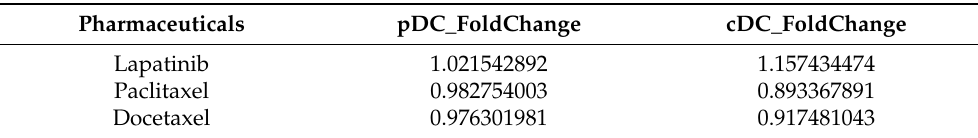
Table 2. Calculation of the fold changes in the sensitivities of the pDC and cDC groups to three chemotherapeutic